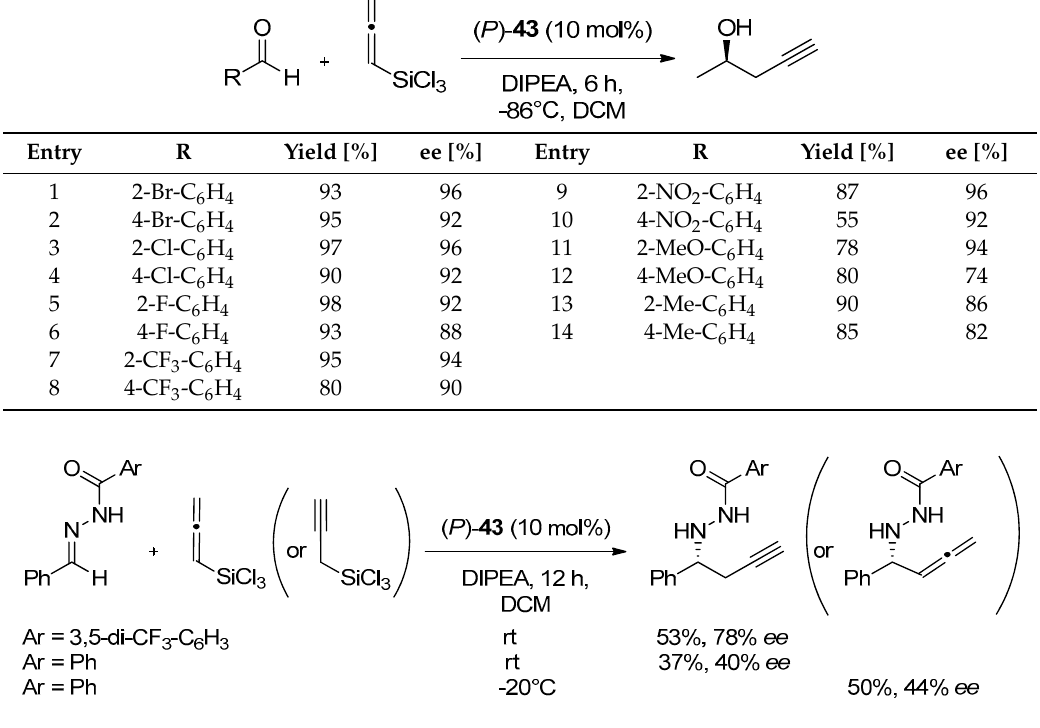
Table 8. Asymmetric propargylation of aldehydes catalyzed by ( P )- 43